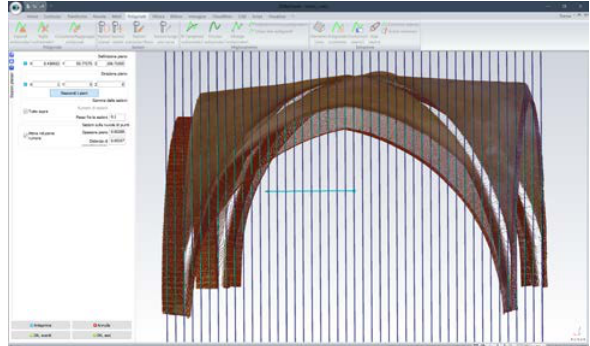
Figure 3. Planar sections on X plane. Distance between planes 10 cm and a planes thickness of 2,8 mm.